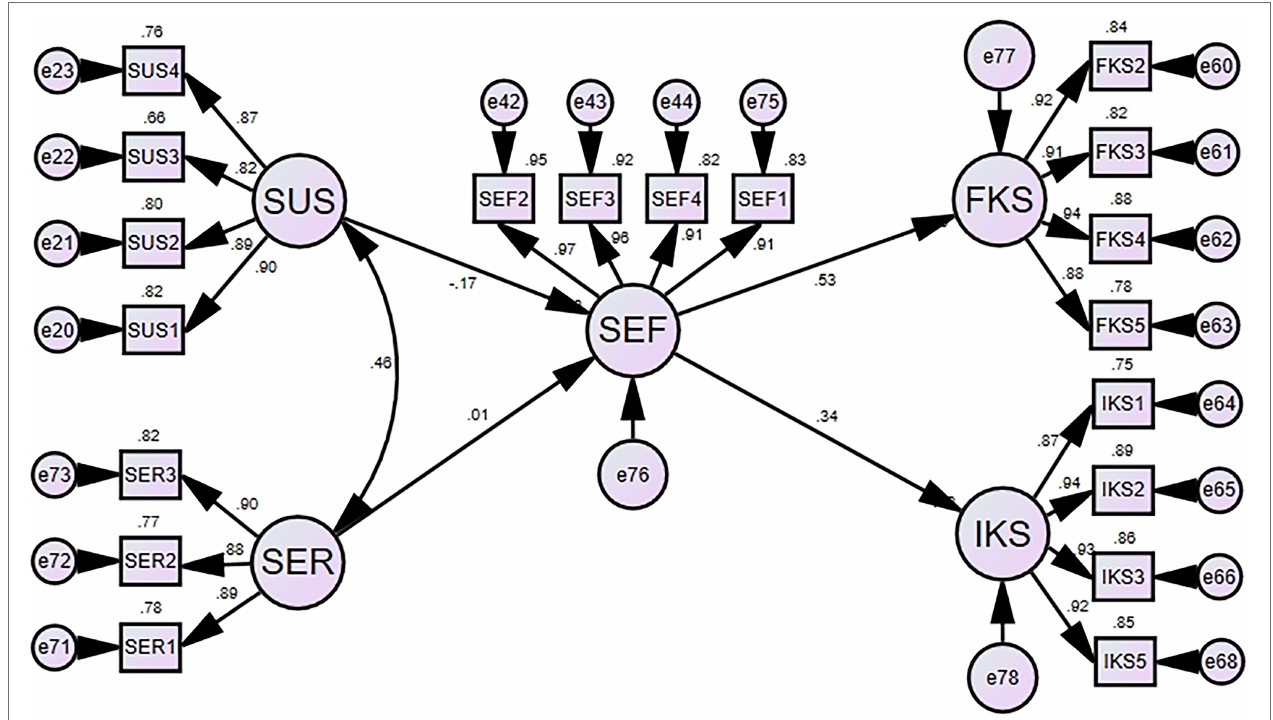
FIGURE 1 | Structural model